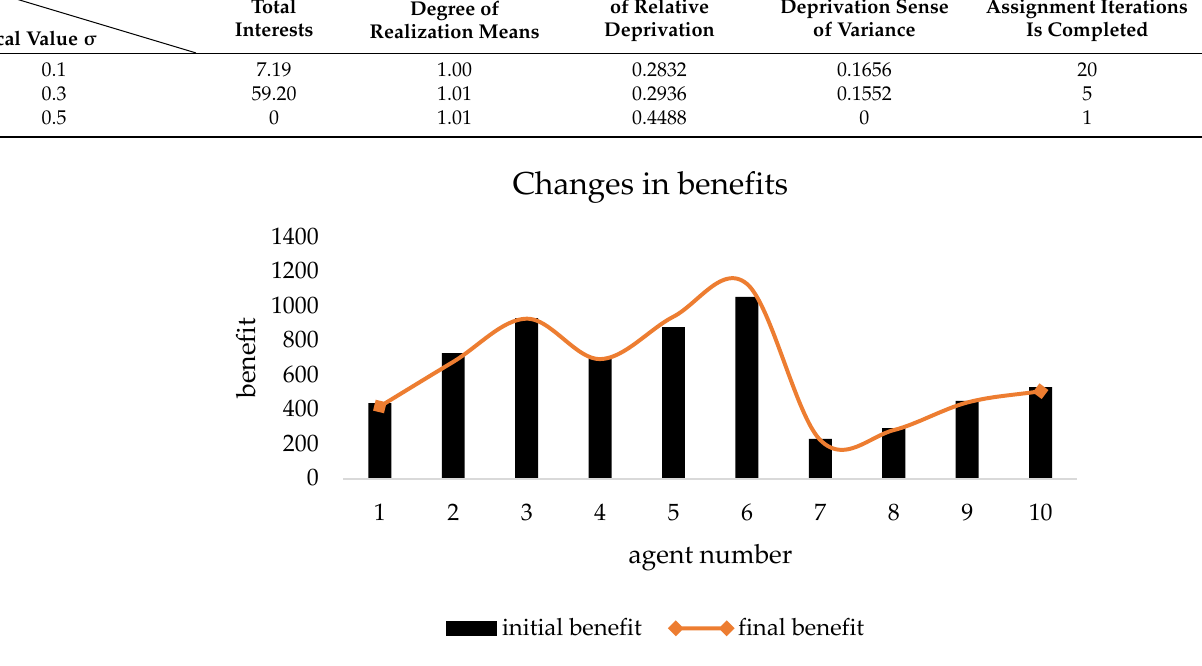
Figure 9. Changes in agent benefits.